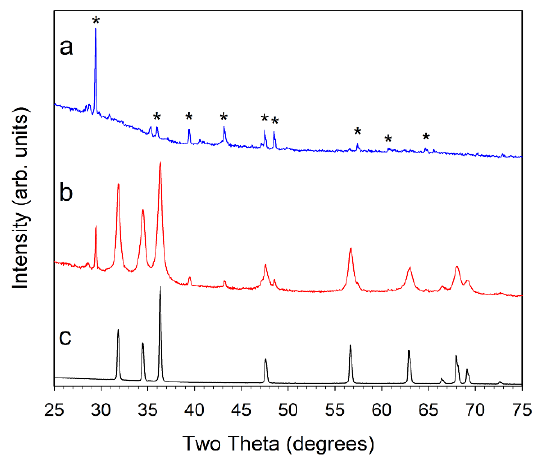
Figure 2. Powder XRD results for ( a , blue) ZZ-res; ( b , red) ZZ-ZnO; and ( c , black) comm-ZnO. The major peaks for calcite CaCO 3 are marked with a * symbol in ( a ) for the ZZ-res sample. Small peak near 28.5 ◦ is consistent with KCl.